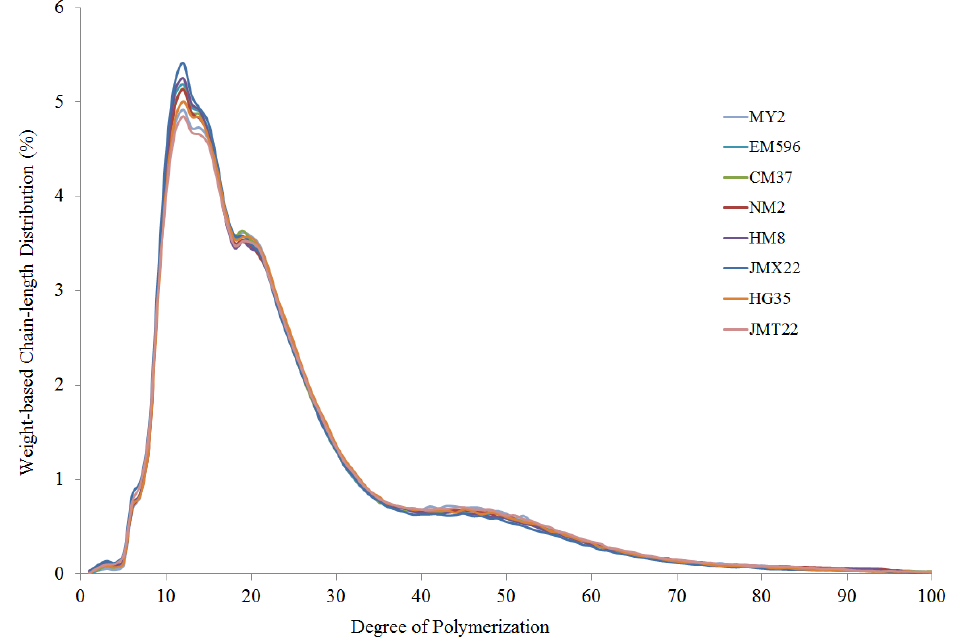
Figure 3. FTIR spectra of starch from wheat varying in grain hardness.